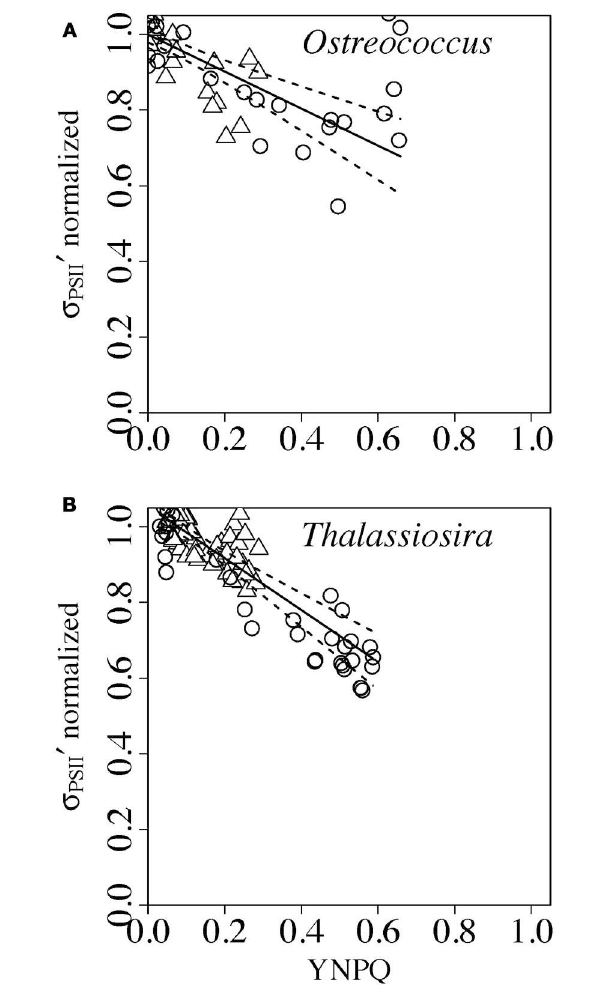
FIGURE 6 | Normalized σ PSII ′ vs. YNPQ in Ostreococcus (A) or Thalassiosira (B) from growth-limiting (open triangles) or growth saturating light (open circles). Induction of YNPQ was driven by increasing actinic light ( Figure 1A ). σ PSII ′ was normalized to the regression intercept for a particular data set ( Figure 4 ) to scale change in σ PSII ′ from 1 to 0. Paired determinations from 4 to 8 replicate cultures plotted individually. Solid lines show linear regressions; dotted lines show 95% C.I. on the regression lines.